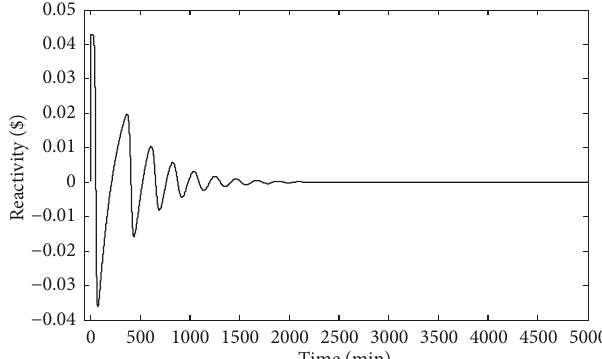
Figure 5: Reactivity versus time for thermal hydraulic feedback problem.